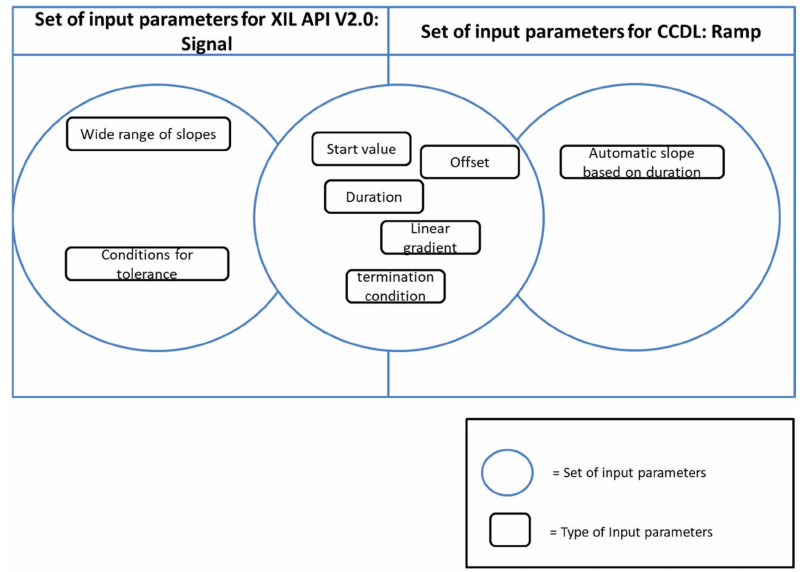
Figure 4. The intersection of the input parameters for the ramp function in XIL and